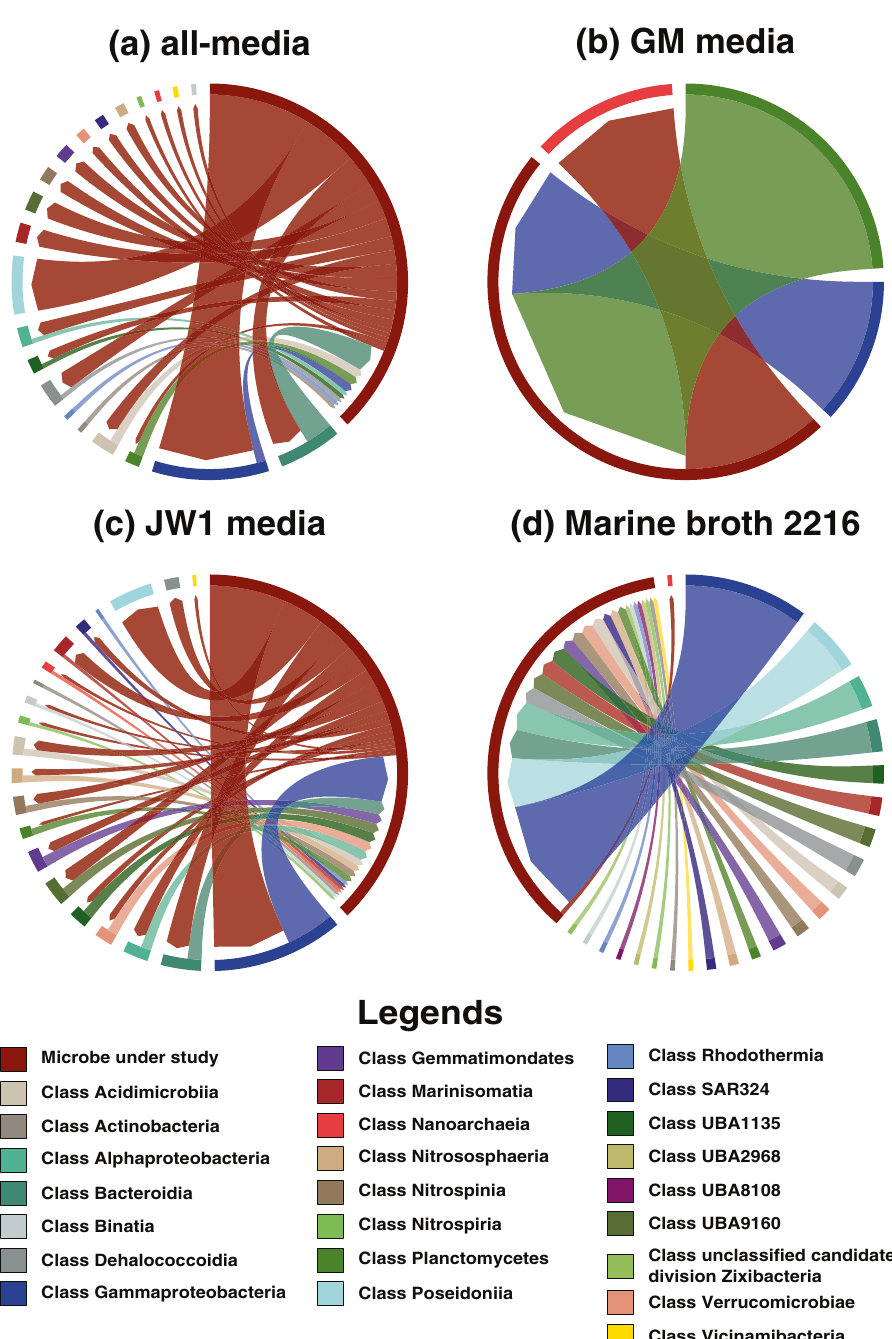
Fig. 5 Pairwise MSI interactions of Candidatus Handelsmanbacteria bacterium UWMA 0286 with other microbes in the community. This chord diagram shows all possible metabolic interactions between Candidatus Handelsmanbacteria bacterium UWMA 0286 and other microbial classes present in the Guaymas microbiome in four different media conditions ( a ) all-media, ( b ) GM media, ( c ) JW1 media, ( d ) Marine Broth 2216. All the interacting microbes are grouped under their corresponding microbial class except Candidatus Handelsmanbacteria bacterium UWMA 0286. The chord starts from the donor microbe/class towards recipient microbe/class. The thickness of the chord represents the number of microbes participating in the interaction from the same class. The colours are mapped to microbial fi ve different Candidatus Thioglobus members represented by Candidatus Thioglobus sp UWMA 0259 (CTB259), Candidatus Thioglobus sp UWMA 0272 (CTB272), Candidatus Thioglobus sp UWMA 0322 (CTB322), Candidatus Thioglobus sp UWMA 0342 (CTB342), Candidatus Thioglobus sp UWMA 0360 (CTB360) interacted extensively with other organisms. First, CTB259 showed consistent interactions with other Gammaproteobacteria in all